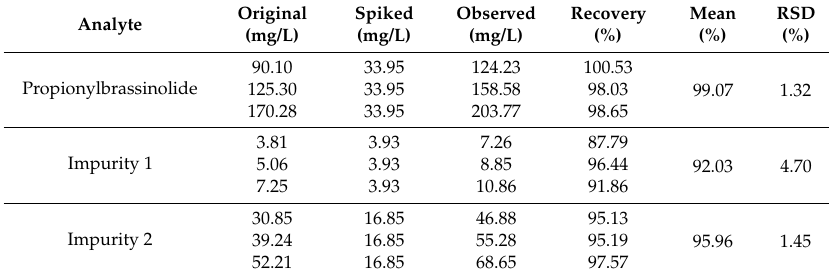
Table 4. Accuracy determination of propionylbrassinolide and two impurities in propionylbrassinolide TC.